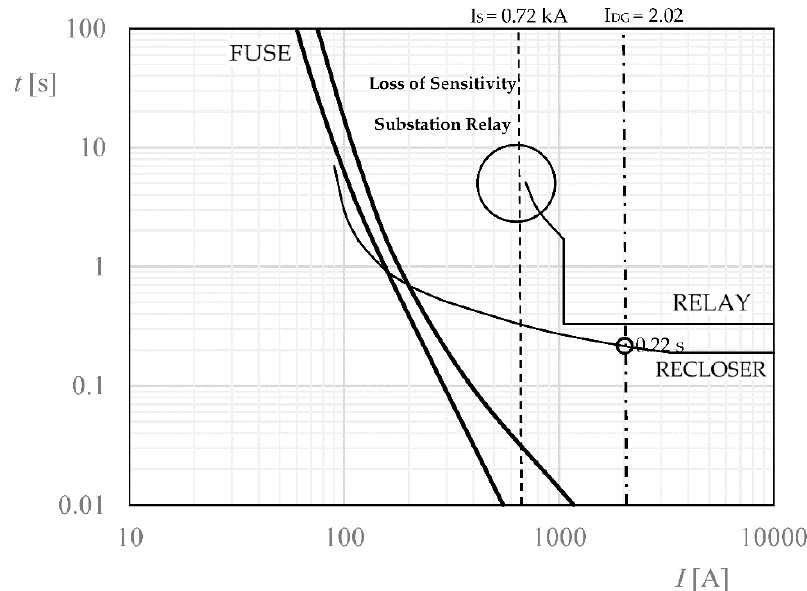
Figure 5. Short loss of sensitivity substation relay. Loss of sensitivity.